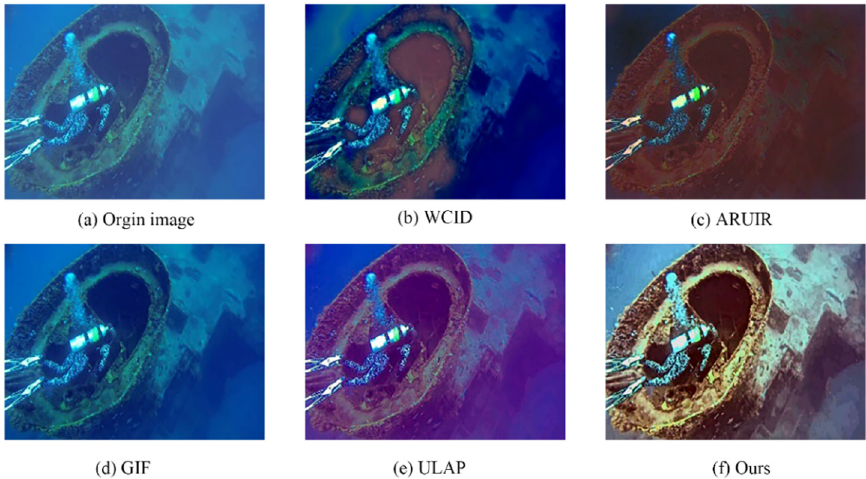
Figure 6. Underwater image enhancement result. ( a ) The origin image. ( b ) The result of WCID; ( c ) the result of ARUIR; ( d ) the result of GIF; ( e ) the result of ULAP; ( f ) the result of ours.